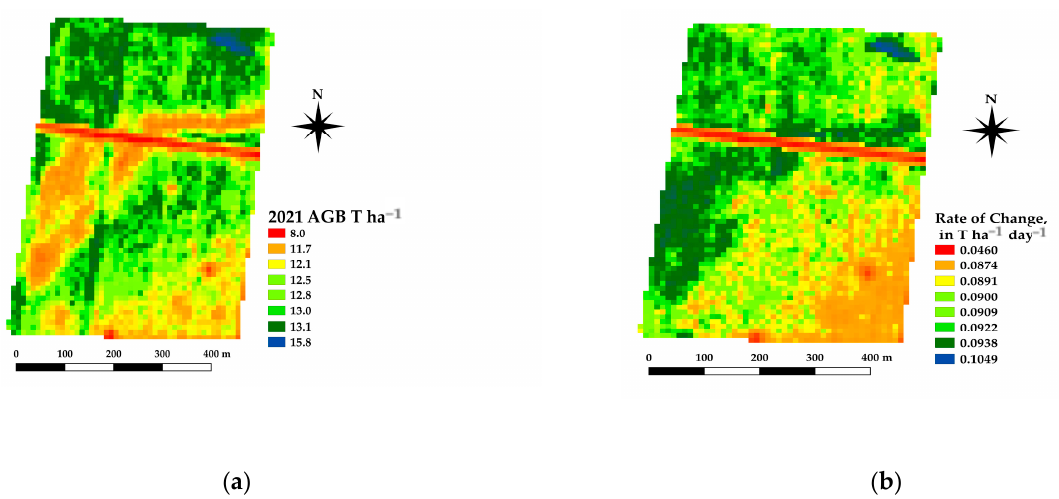
Figure 10. Example estimates of AGB ( a ) and Rate of Change ( b ) for a canola crop at DOY 300, 2021.